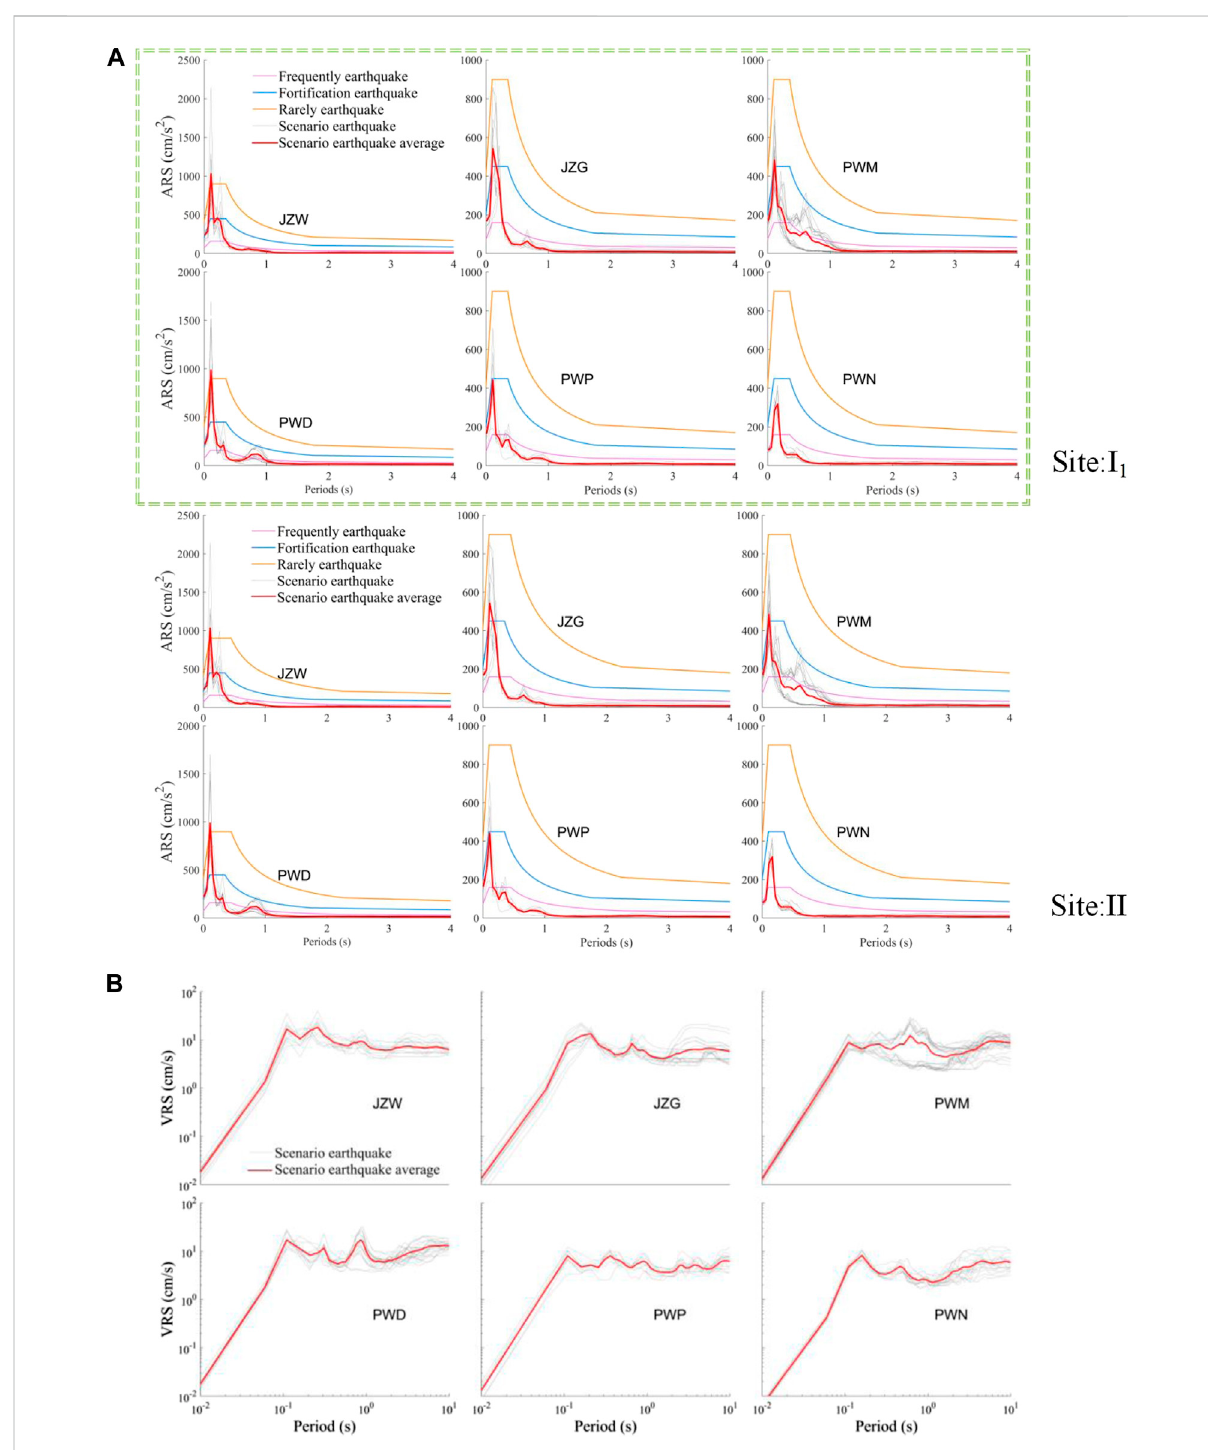
FIGURE 10 Acceleration response spectrum (A) and velocity response spectrum (B) of all scenarios in six typical locations (ARS stands for acceleration response spectrum, and VRS stands for velocity response